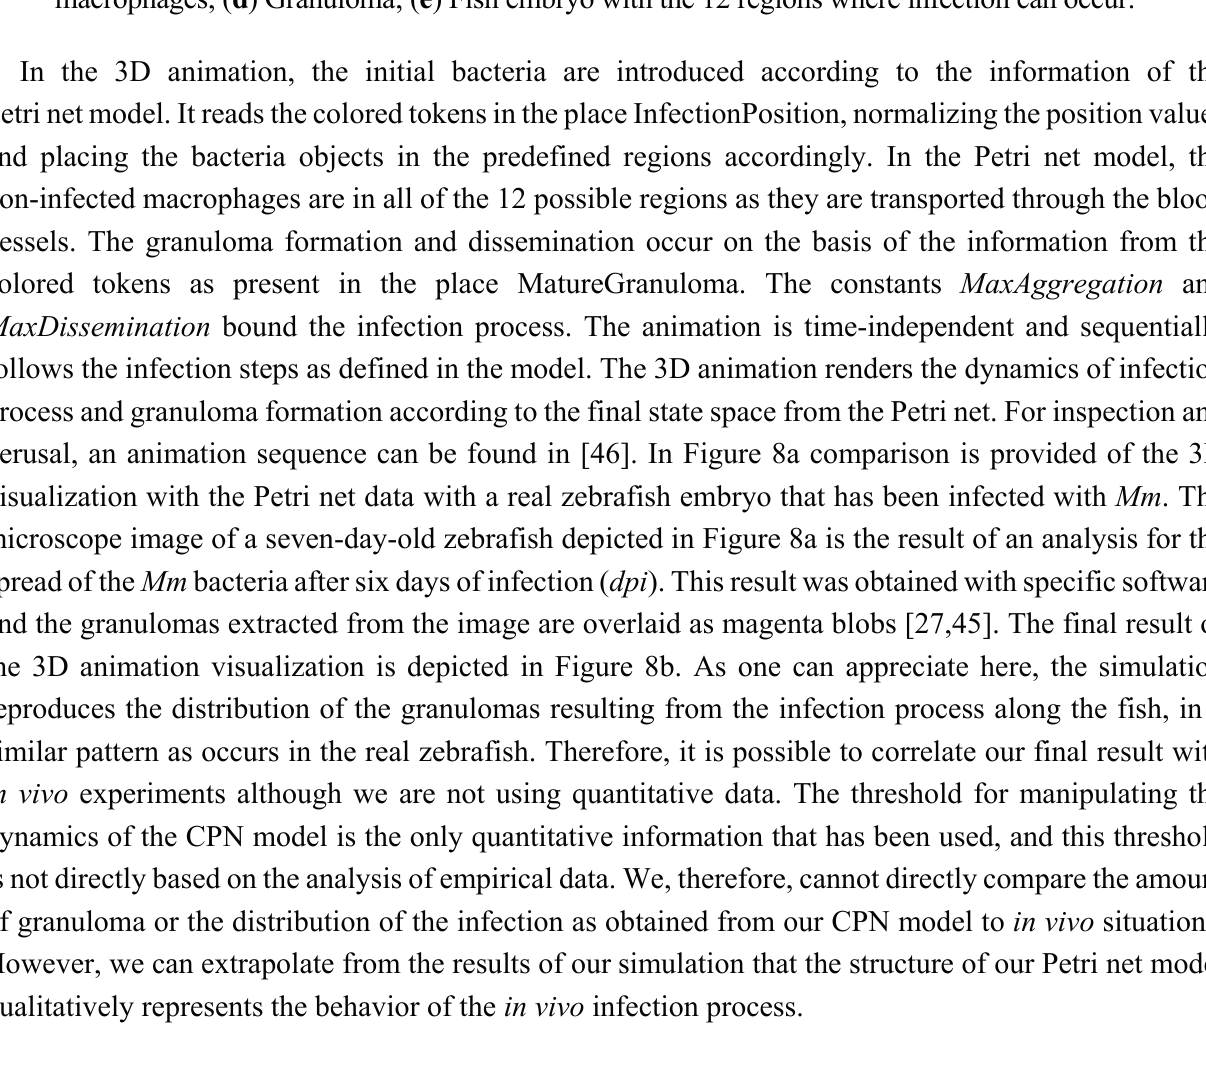
Figure 7. 3D visualization tool and its elements: ( a ) Macrophage; ( b ) Bacteria; ( c ) Infected macrophages; ( d ) Granuloma; ( e ) Fish embryo with the 12 regions where infection can